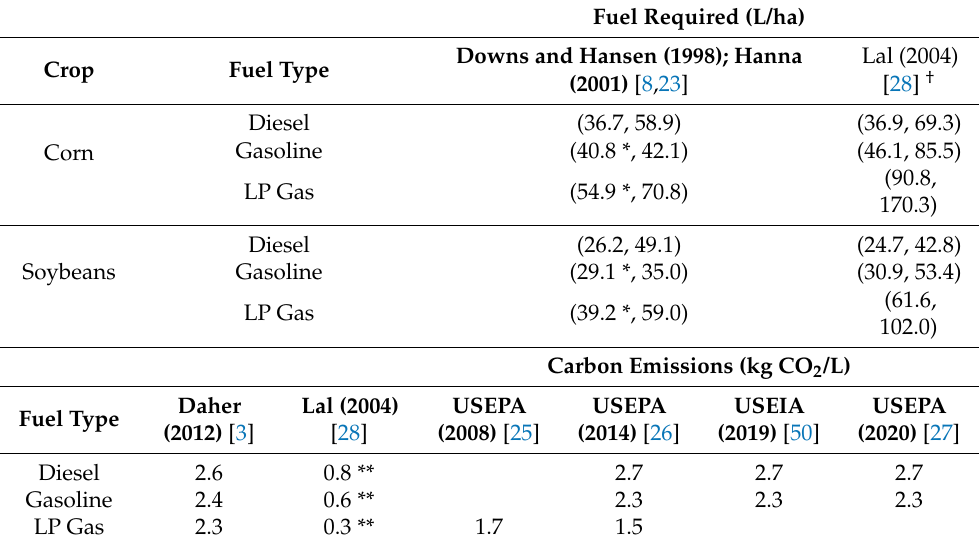
Table 3. Estimated range of fuel required (L/ha) for agronomic practices and management operations based on crop and fuel